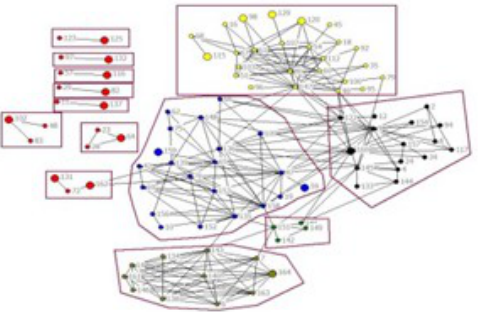
Figure 7. The Community Structure of SSE 180-Index Sample Stock Network with Threshold 0.7